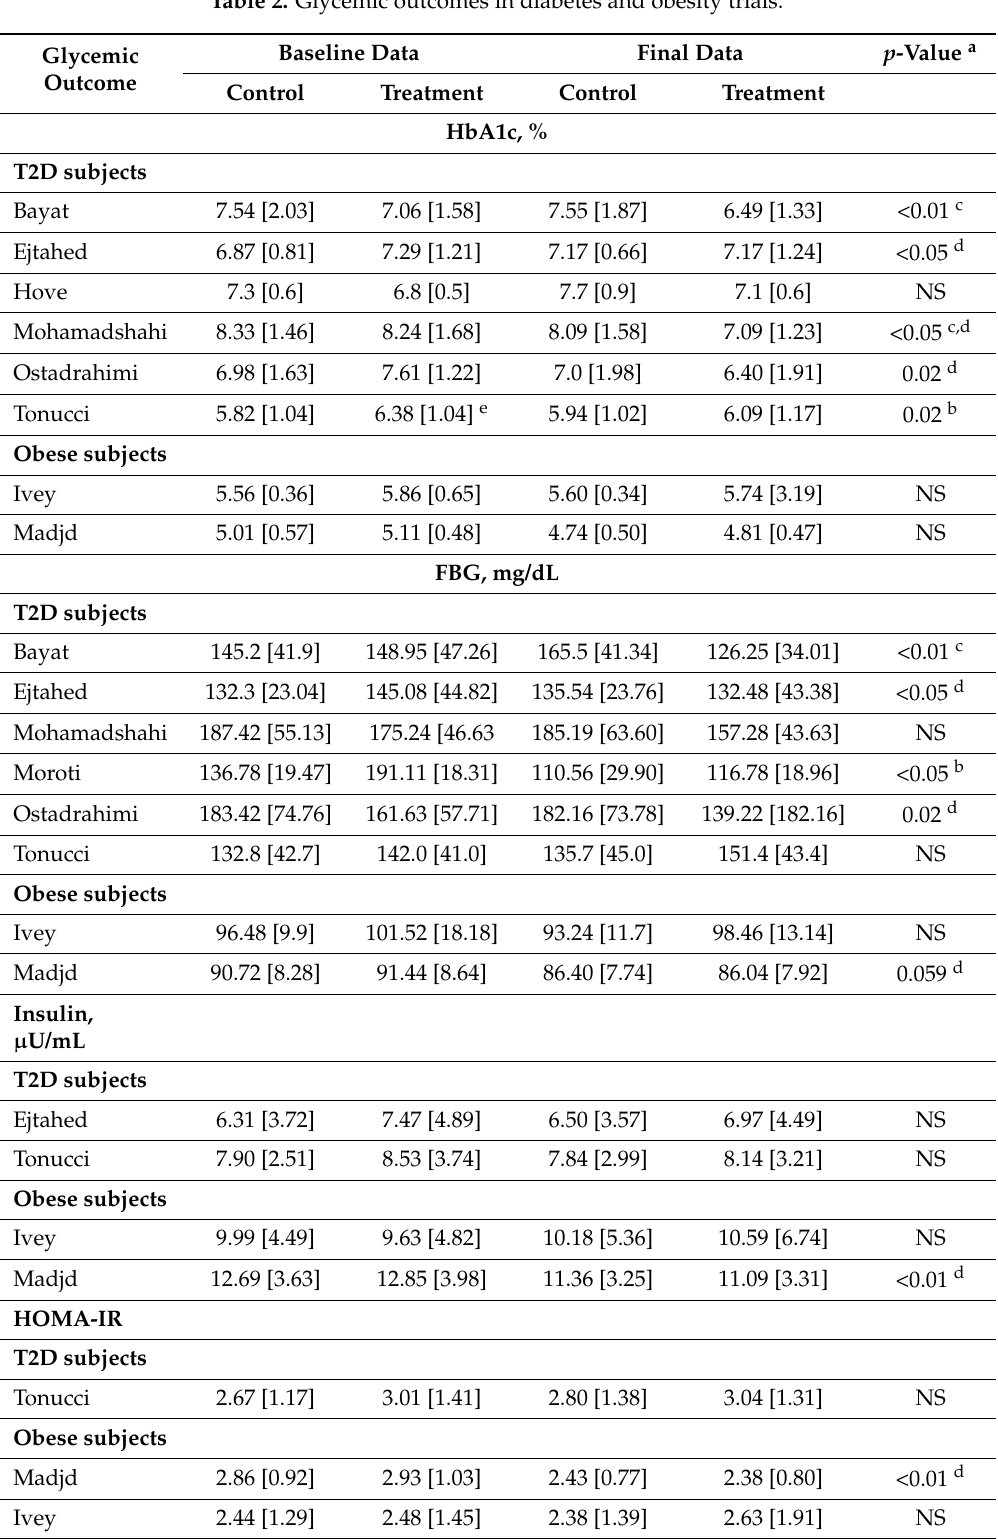
Table 2. Glycemic outcomes in diabetes and obesity